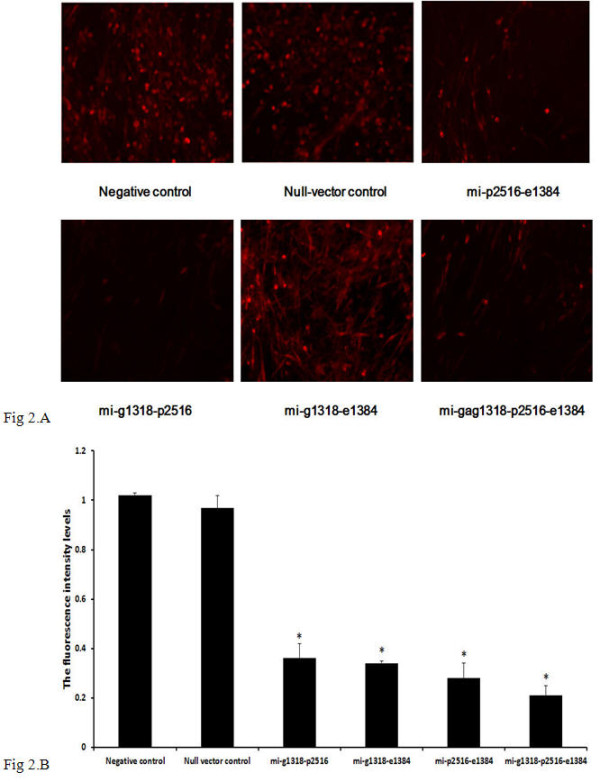
Inhibition of ALV-J replication by miRNA. (A) Cells transfected with the recombinant serial miRNA plasmids and their inhibitory effects against ALV-J, as determined by the IFA. (B) The fluorescence intensity of cells transfected with the recombinant serial miRNA plasmids and their inhibitory effects against ALV-J, as determined by the IFA. Data are presented as means±S.E.M. of three independent experiments, each performed with triplicate samples. *Statistically significant differences compared with negative controls (P<0.05).